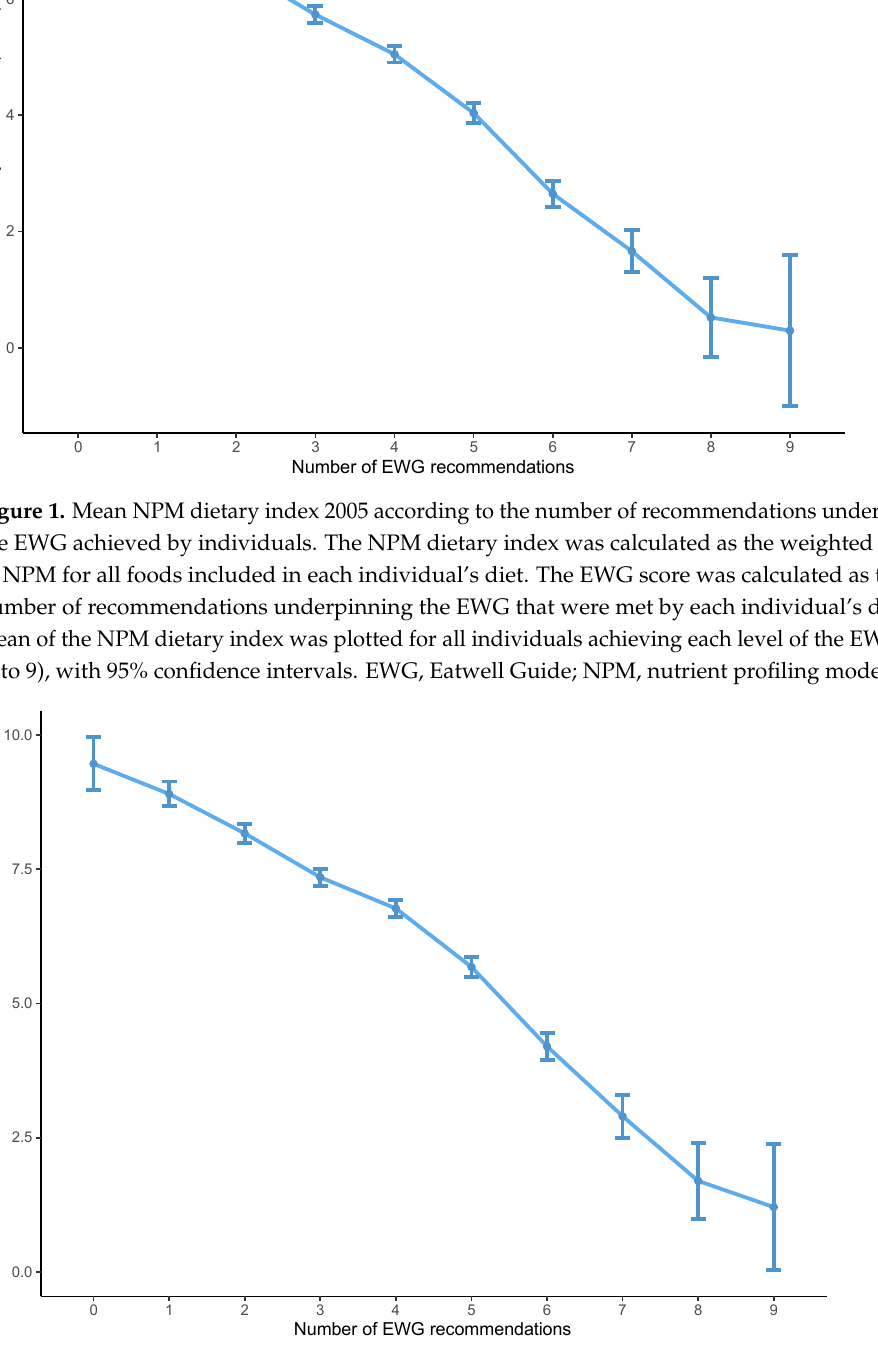
Figure 2. Mean NPM dietary index 2018 according to the number of recommendations underpinning the EWG achieved by individuals. The NPM dietary index was calculated as the weighted average of NPM for all foods included in each individual’s diet. The EWG score was calculated as the total number of recommendations underpinning the EWG that were met by each individual’s diet. The mean of the NPM dietary index was plotted for all individuals achieving each level of the EWG score (0 to 9), with 95% confidence intervals. EWG, Eatwell Guide; NPM, nutrient profiling model.